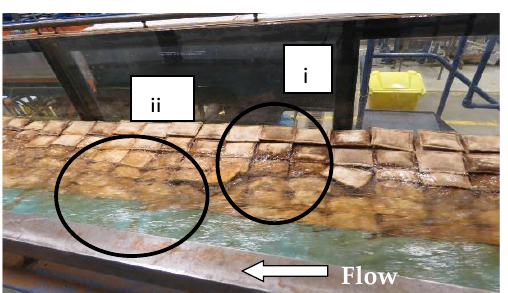
Figure 7. Failure due to sliding.